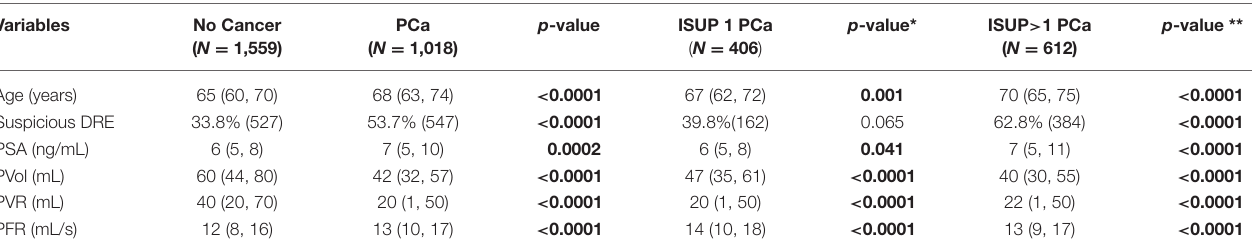
TABLE 1 | Patients descriptive characteristics.